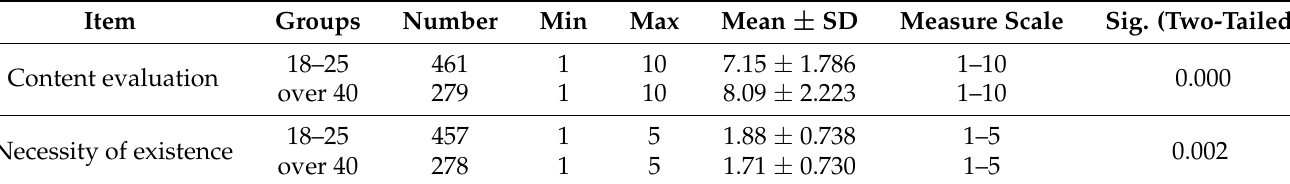
Table 7. Content evaluation and necessity of public-interest SMS in different ages.